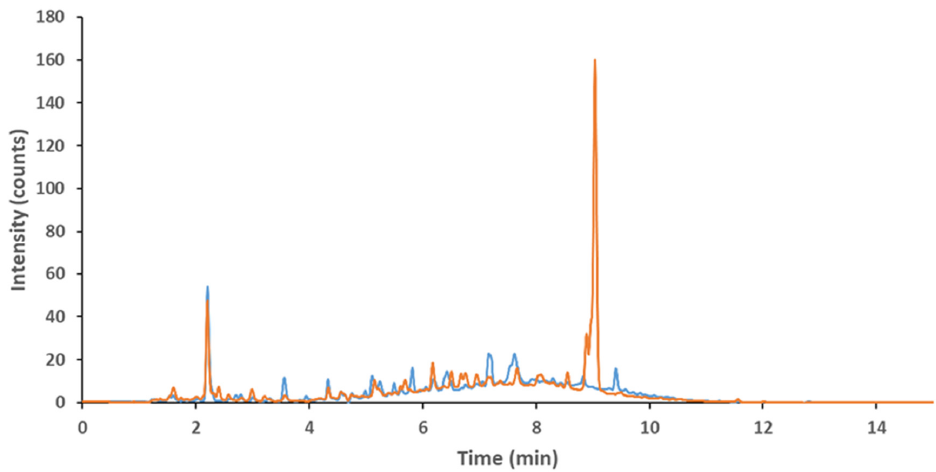
Figure 1. Comparison between OMWW (blue) and enzymatic treated OMWW (orange).